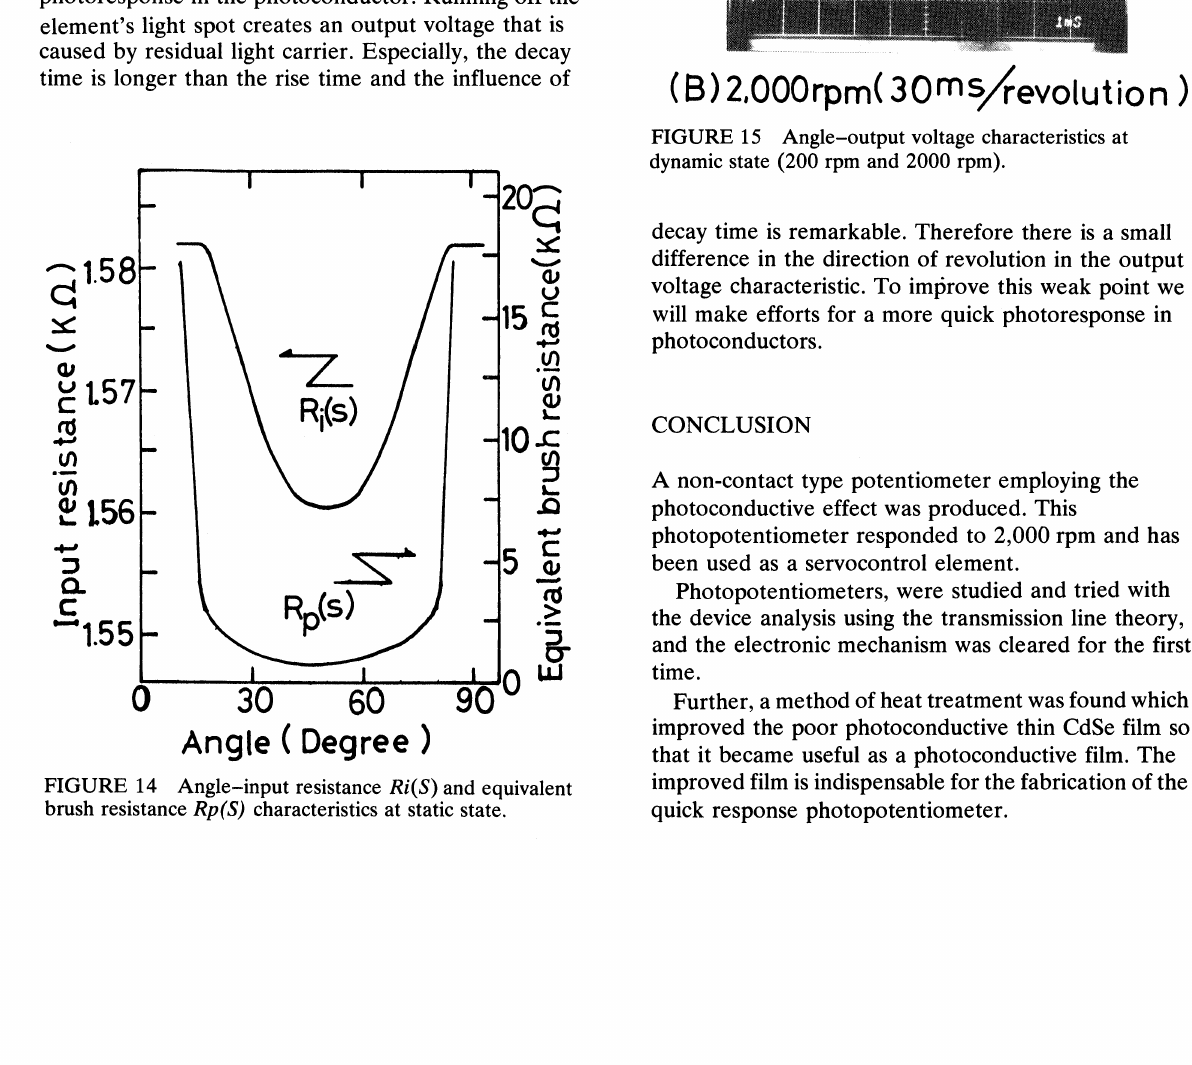
FIGURE 15 Angle-output voltage characteristics at dynamic state (200 rpm and 2000